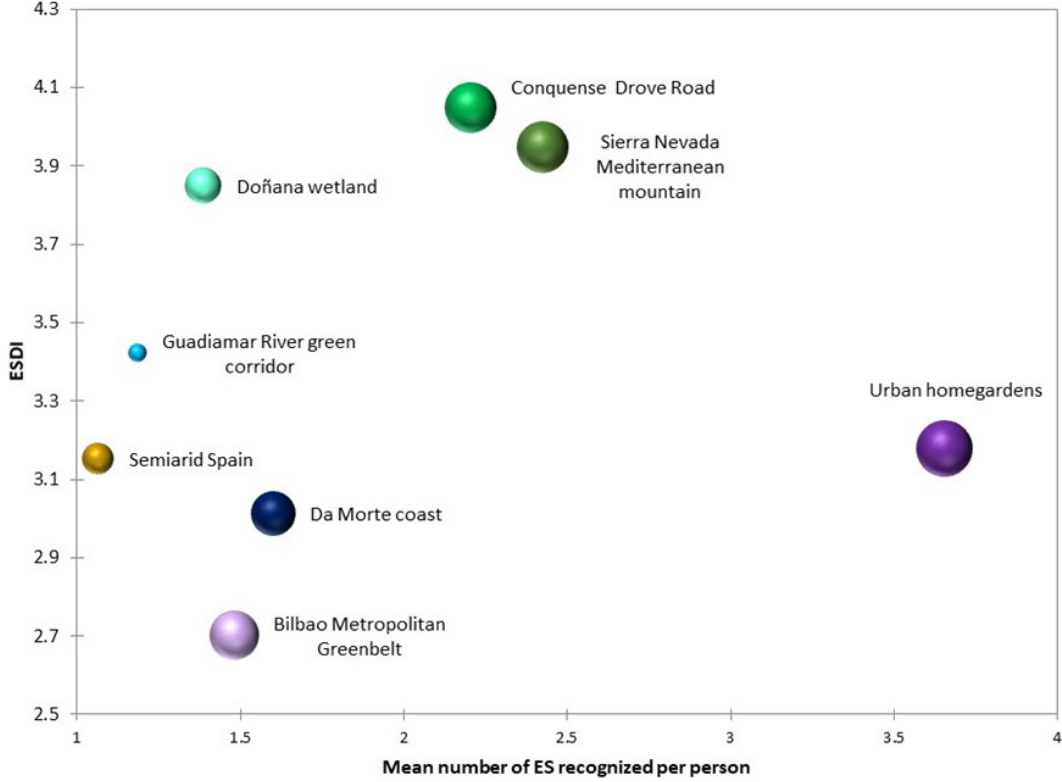
Figure 3. Scatter plot representing the social importance of ecosystem services (ES) (mean number of ES recognized per person) and the ES diversity index (ESDI) per ecosystem type. The bubble size indicates the percentage (%) of respondents who named at least one example of